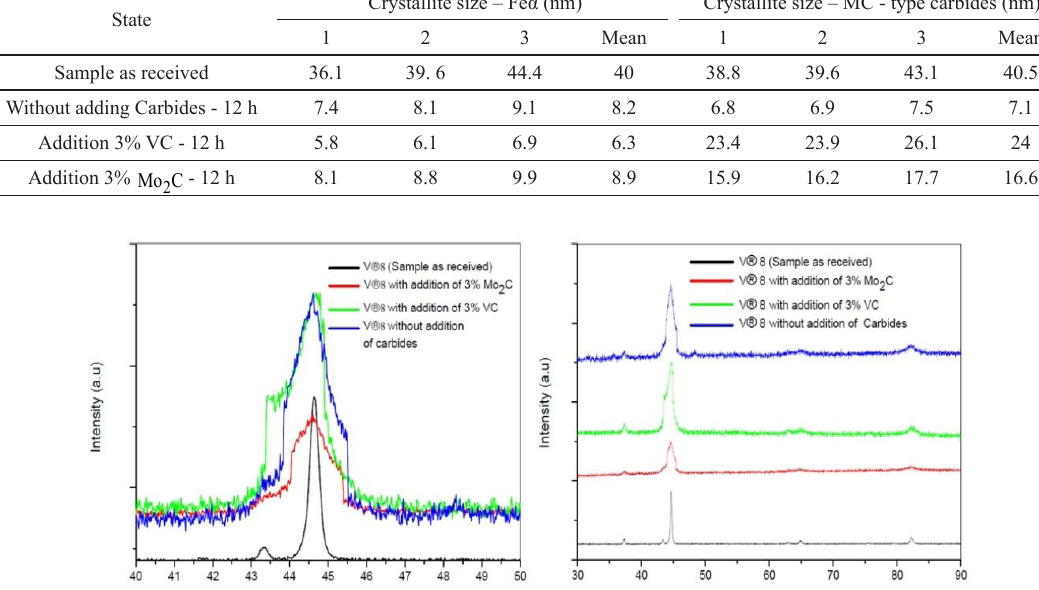
Crystallite size – Feα (nm)